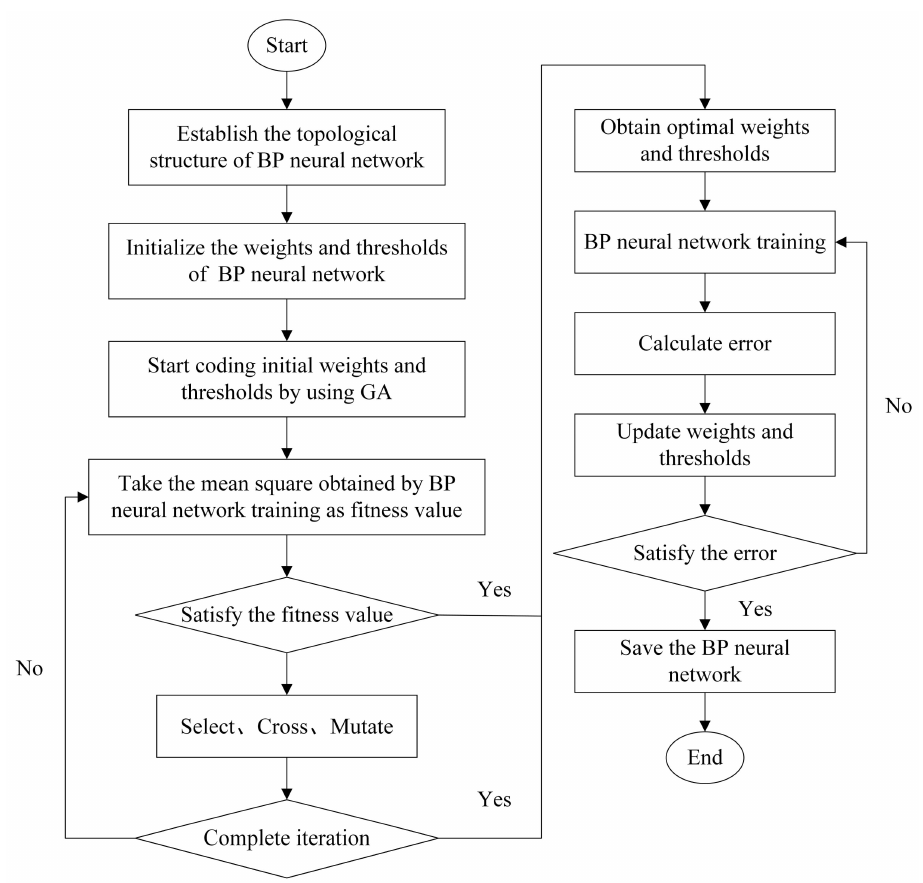
Figure 9. Flowchart of the GABP neural